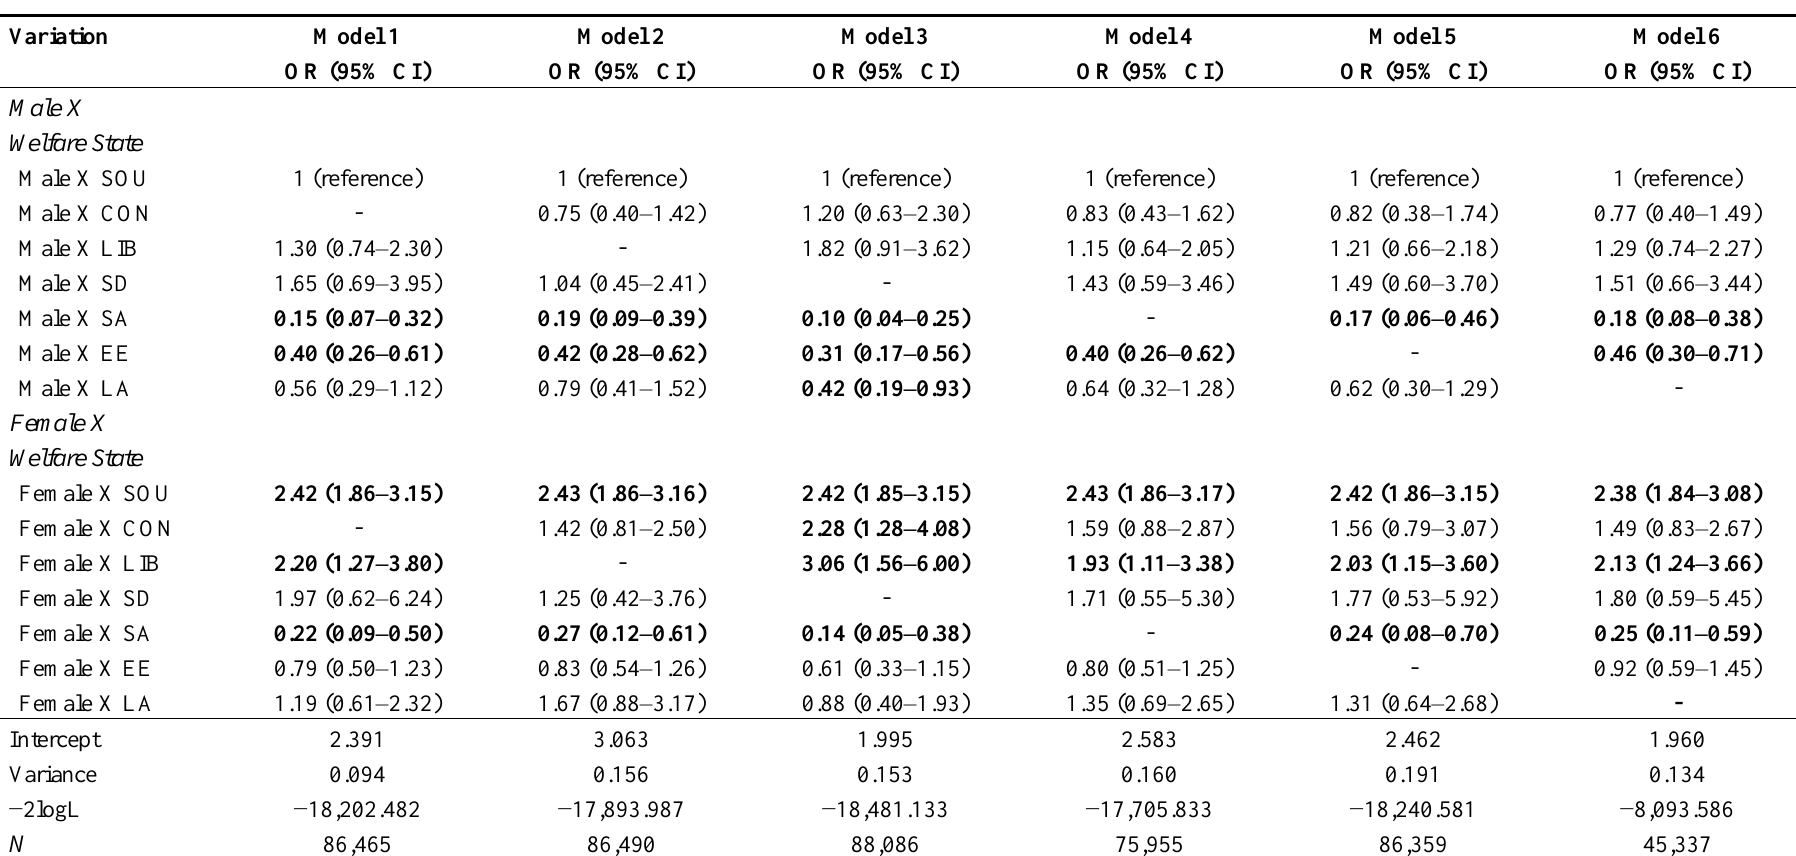
Table A1. Sensitivity analyses, stepwise exclusion of individual welfare regimes in interactive